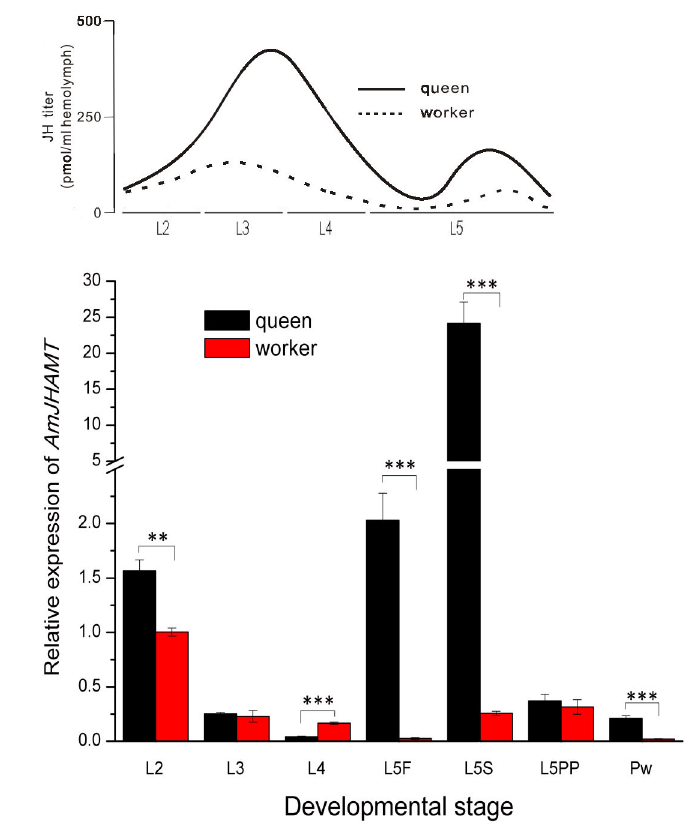
Figure 5. Quantitative real-time PCR analysis of AmJHAMT expression during honey bee caste development. The study covered early larval stage to initial pupal stage, including the second (L2), third (L3), fourth (L4), fifth (L5) instar larvae and white- eyed pupae (Pw). The L5 was subdivided into three stages known as the feeding stage (L5F), spinning stage (L5S), and prepupal stage (L5PP). Values are expressed as mean ± SEM (n = 3). Statistically significant differences are indicated by asterisks (independent-sample t -test, ** P < 0.01, *** P < 0.001). JH titers displayed above are based on data from Hartfelder and Engels [2]. doi: